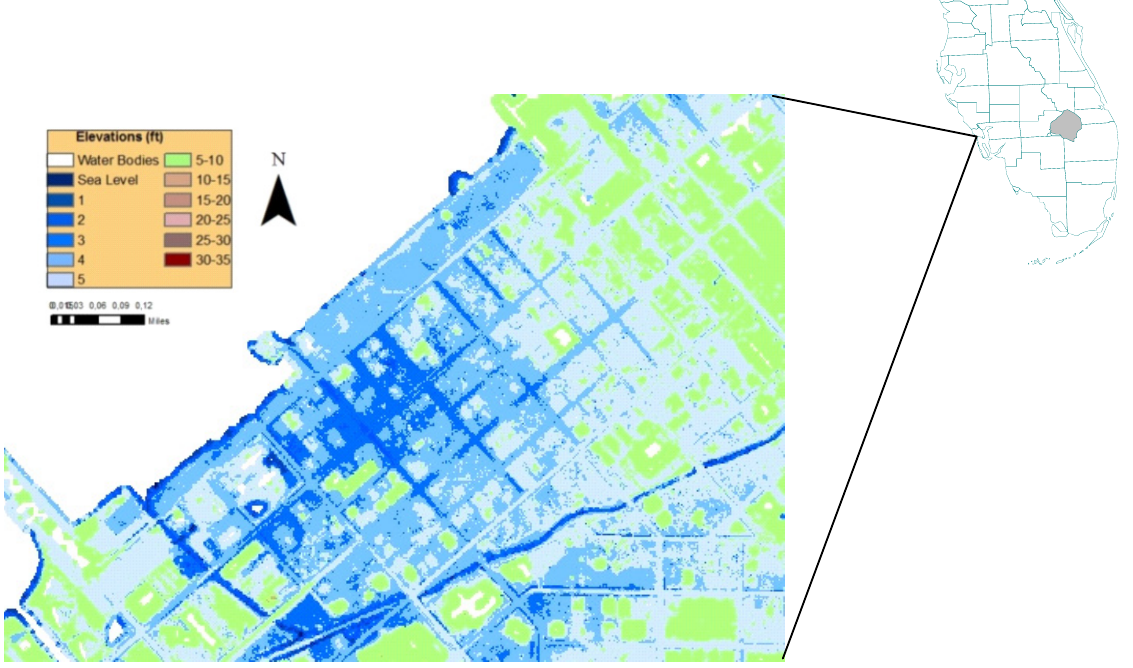
Figure 4. Example of impact of sea level rise on low lying coastal communities. Blue is permanent inundation at 3 ft seal level